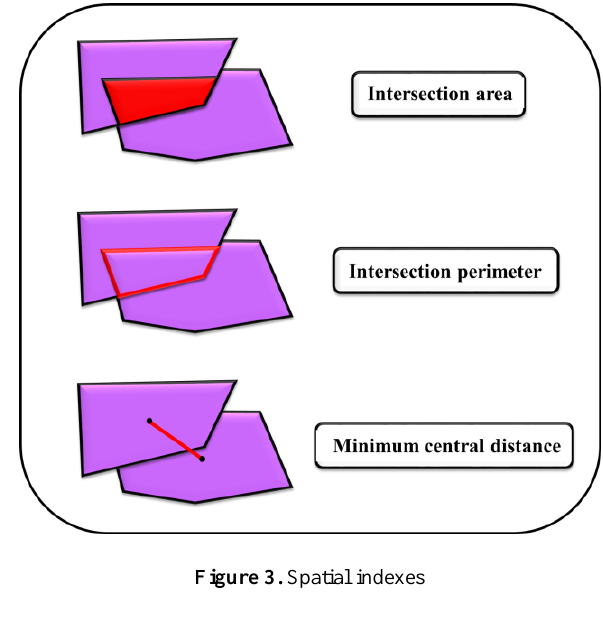
Figure 3. Spatial indexes